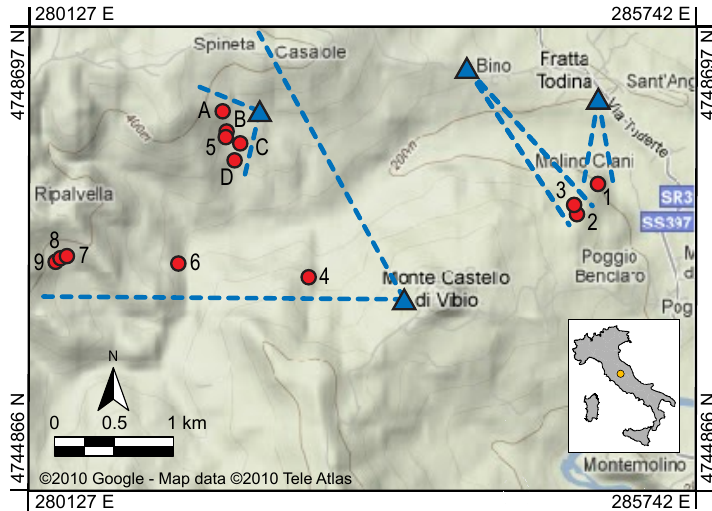
Fig. 2. Landslide event inventory map for the Monte Castello di Vibio area, Umbria, Central Italy. Red dots show the location of 13 landslides mapped through the visual reconnaissance survey and using the rangefinder binocular and GPS. Blue triangles show location of four viewpoints, and dashed lines identify fields of view. Numbers (1–9) identify landslides mapped through the reconnaissance survey and using the rangefinder binocular. Letters (A–D) identify slope failures mapped also by walking the GPS receiver along the landslide perimeter (see Fig. 3). Source of base maps: © 2010 Google – Map data, and © 2010 Tele